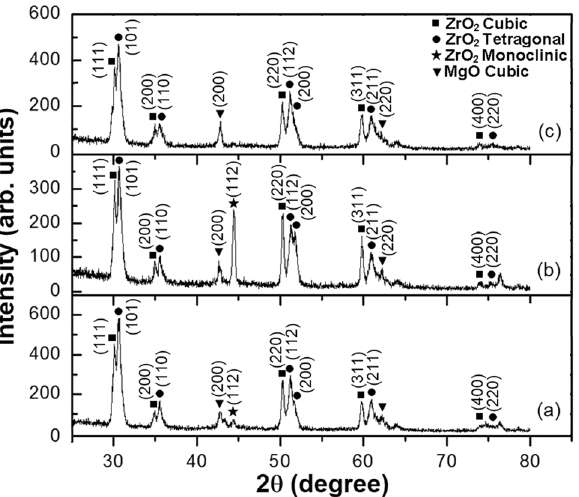
Figure 3. XRD patterns of the as-sprayed mixed CSZ-MSZ coatings with plasma spraying input currents. Coatings in ( a ), ( b ), and ( c ) were corresponding to samples Mix1, Mix2, and Mix3, which were carried out at plasma spraying current of 600, 650, and 700 A, respectively.